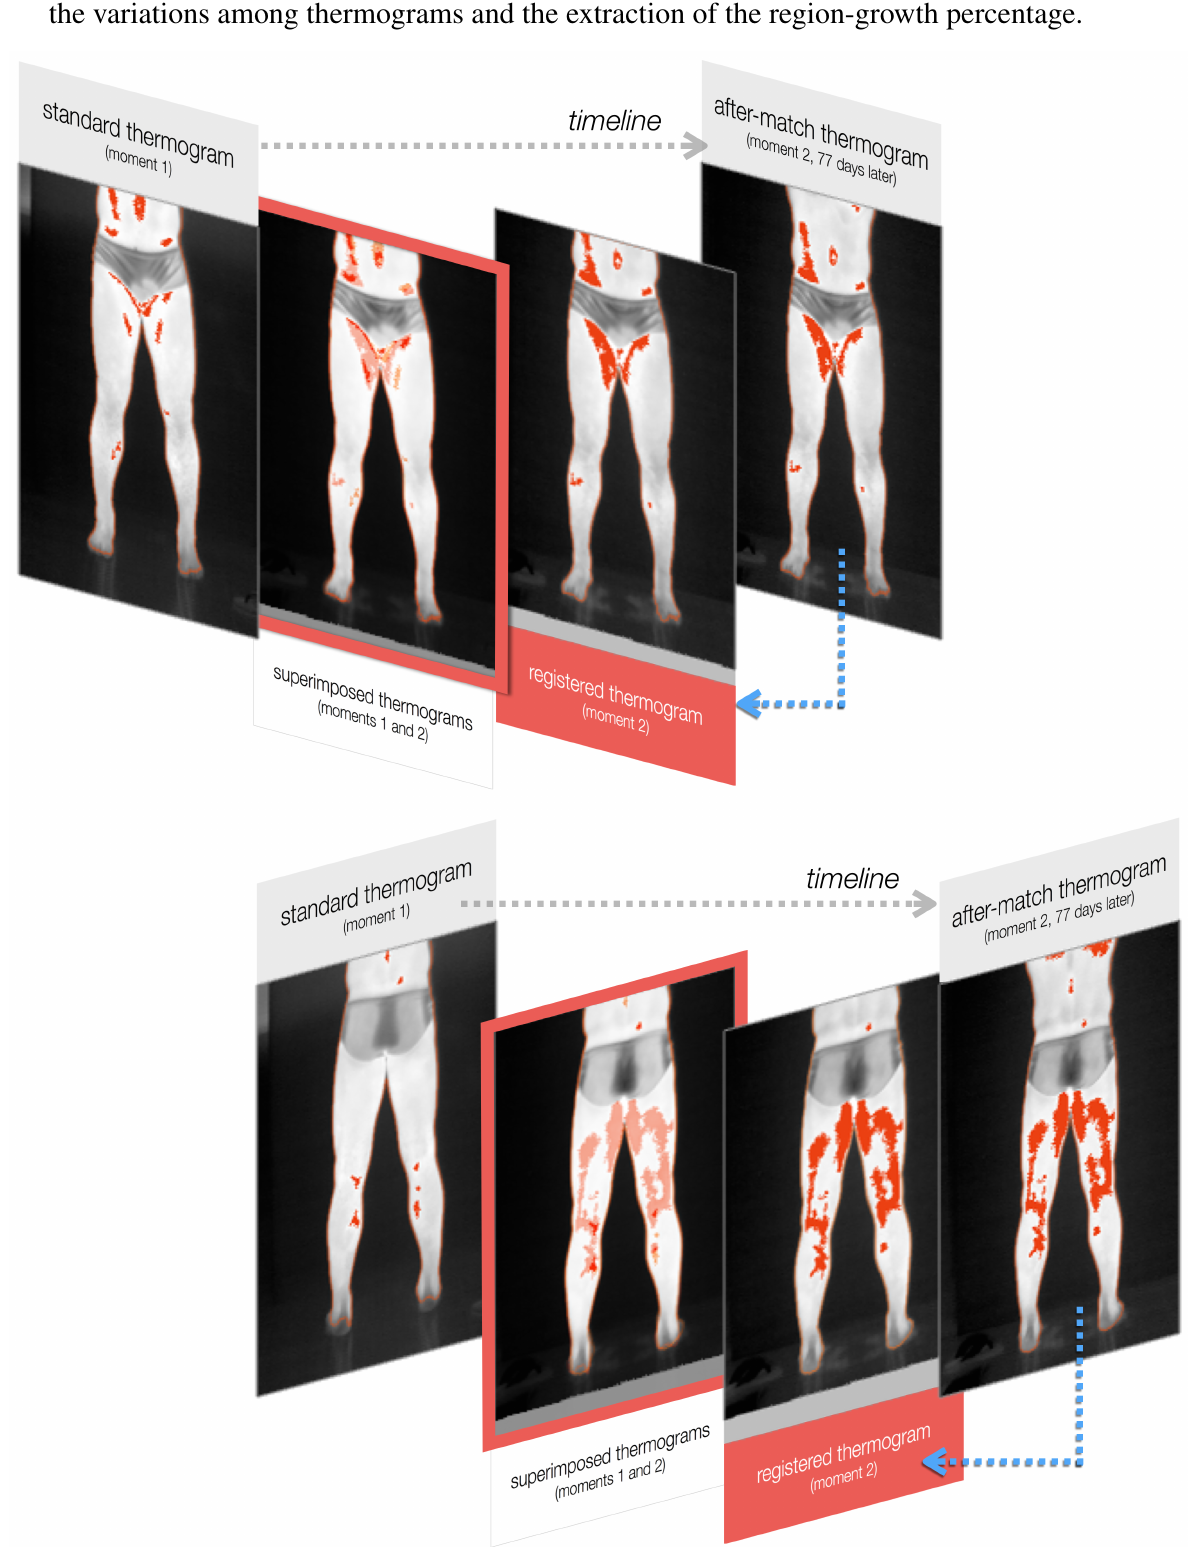
Figure 8. Experiment illustrating the registration of two frontal and two dorsal thermograms of the same athlete, captured 77 days apart. For each set of tests, the left and right images are the original thermograms. The third image is the result of the proposed registration method. The second image (in a red frame) is an overlay of the original thermogram in moment m 1 with the registered thermogram of moment m . This approach allows for the assessment of 2 the variations among thermograms and the extraction of the region-growth